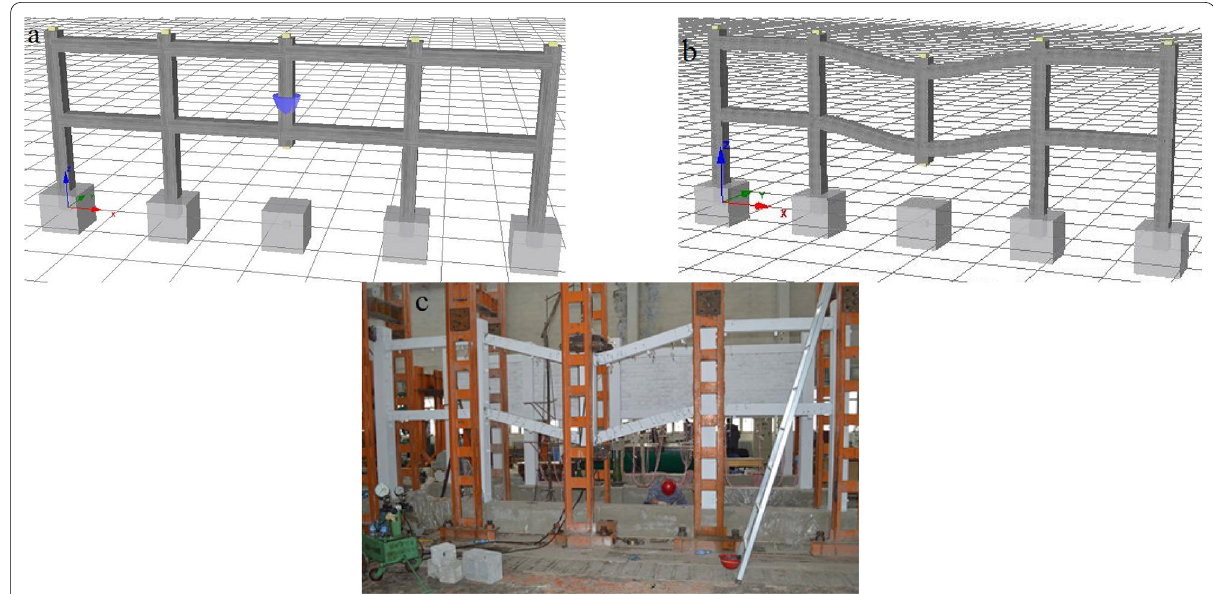
Fig. 2 a Undeformed and b deformed shapes of the case-study frame and c deformed shape of the Li studied specimen (Li et al., 2016).